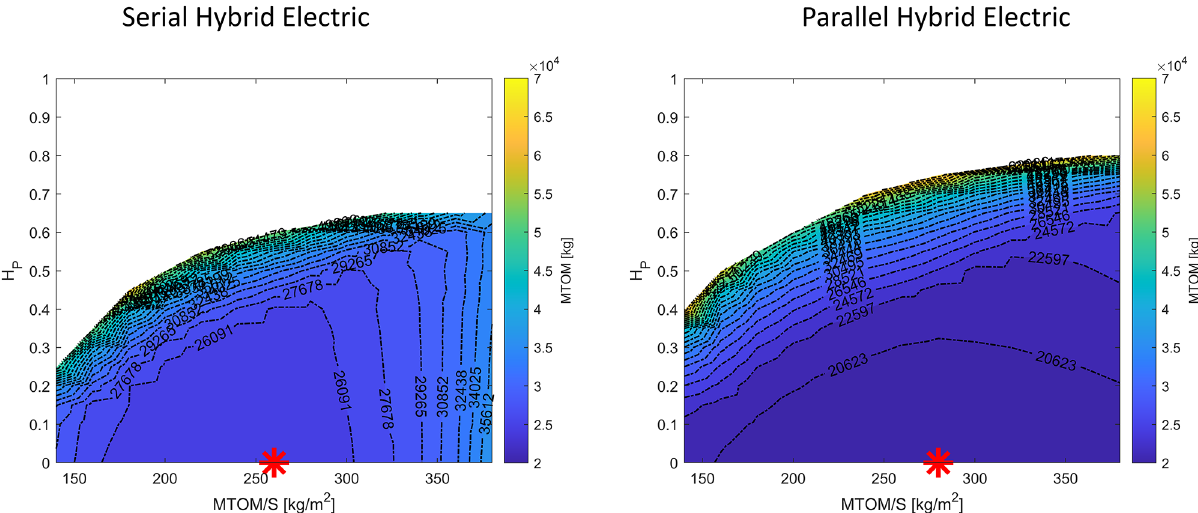
Fig. 9. Comparison of serial and parallel hybrid architecture in terms of